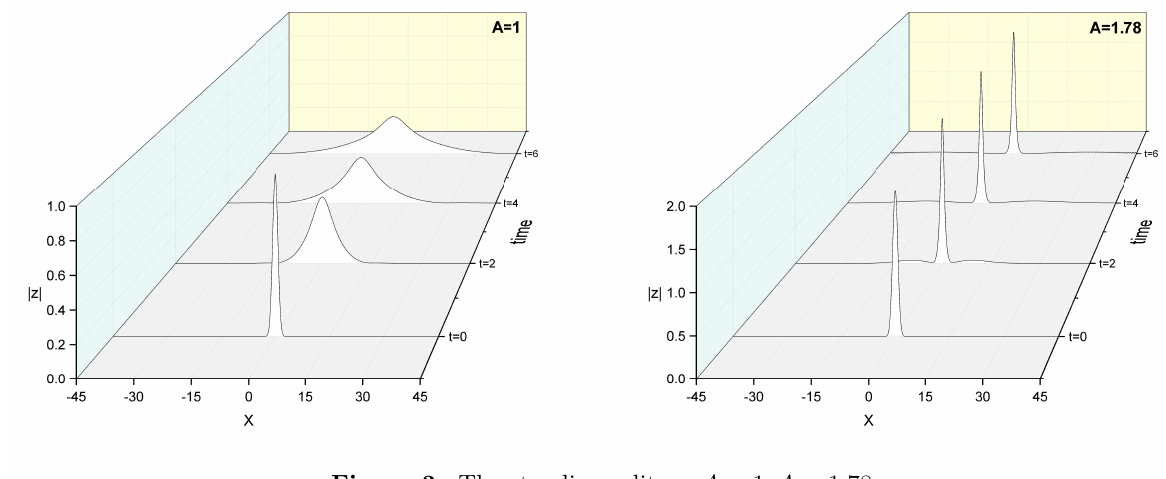
Figure 3. The standing soliton: A = 1 , A = 1 . 78 . Table 7. Invariants and relative change of invariants of formation of standing soliton: A=1.